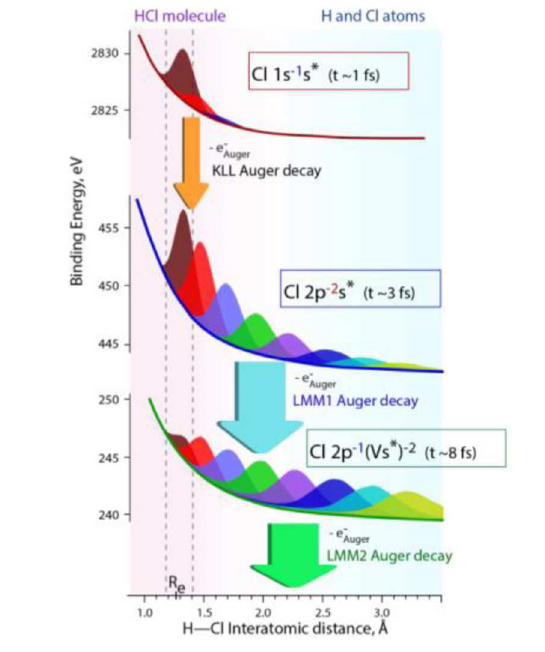
Potential energy curves for different steps of the KLL Auger cascade following Cl 1 s → σ * excitation of the HCl